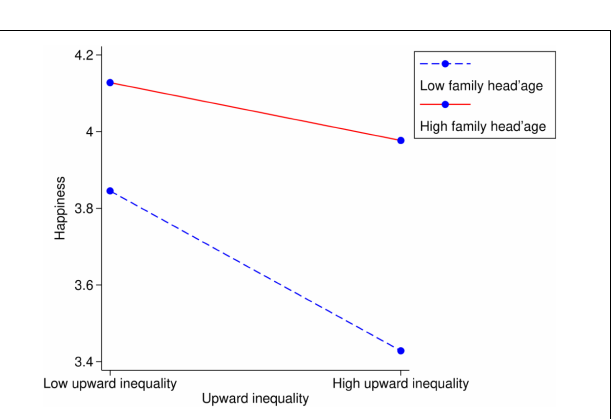
FIGURE 2 | The moderating effect of family life cycle on link between the upward wealth inequality and happiness within old-family-head families (family head’s age ≥